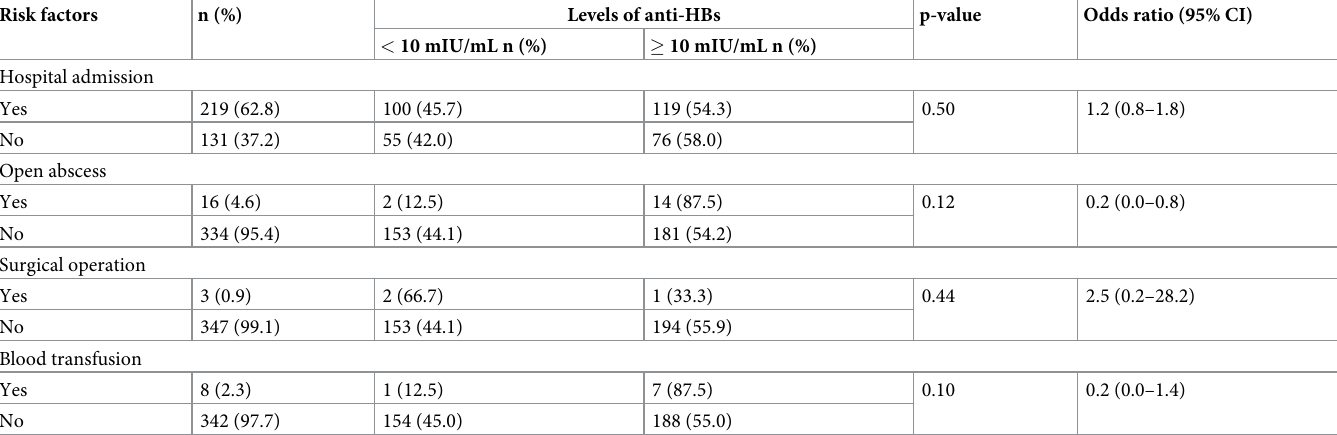
Table 2. Association of participants’ clinical history and sero-protection level n (%) (p-value = 0.29).